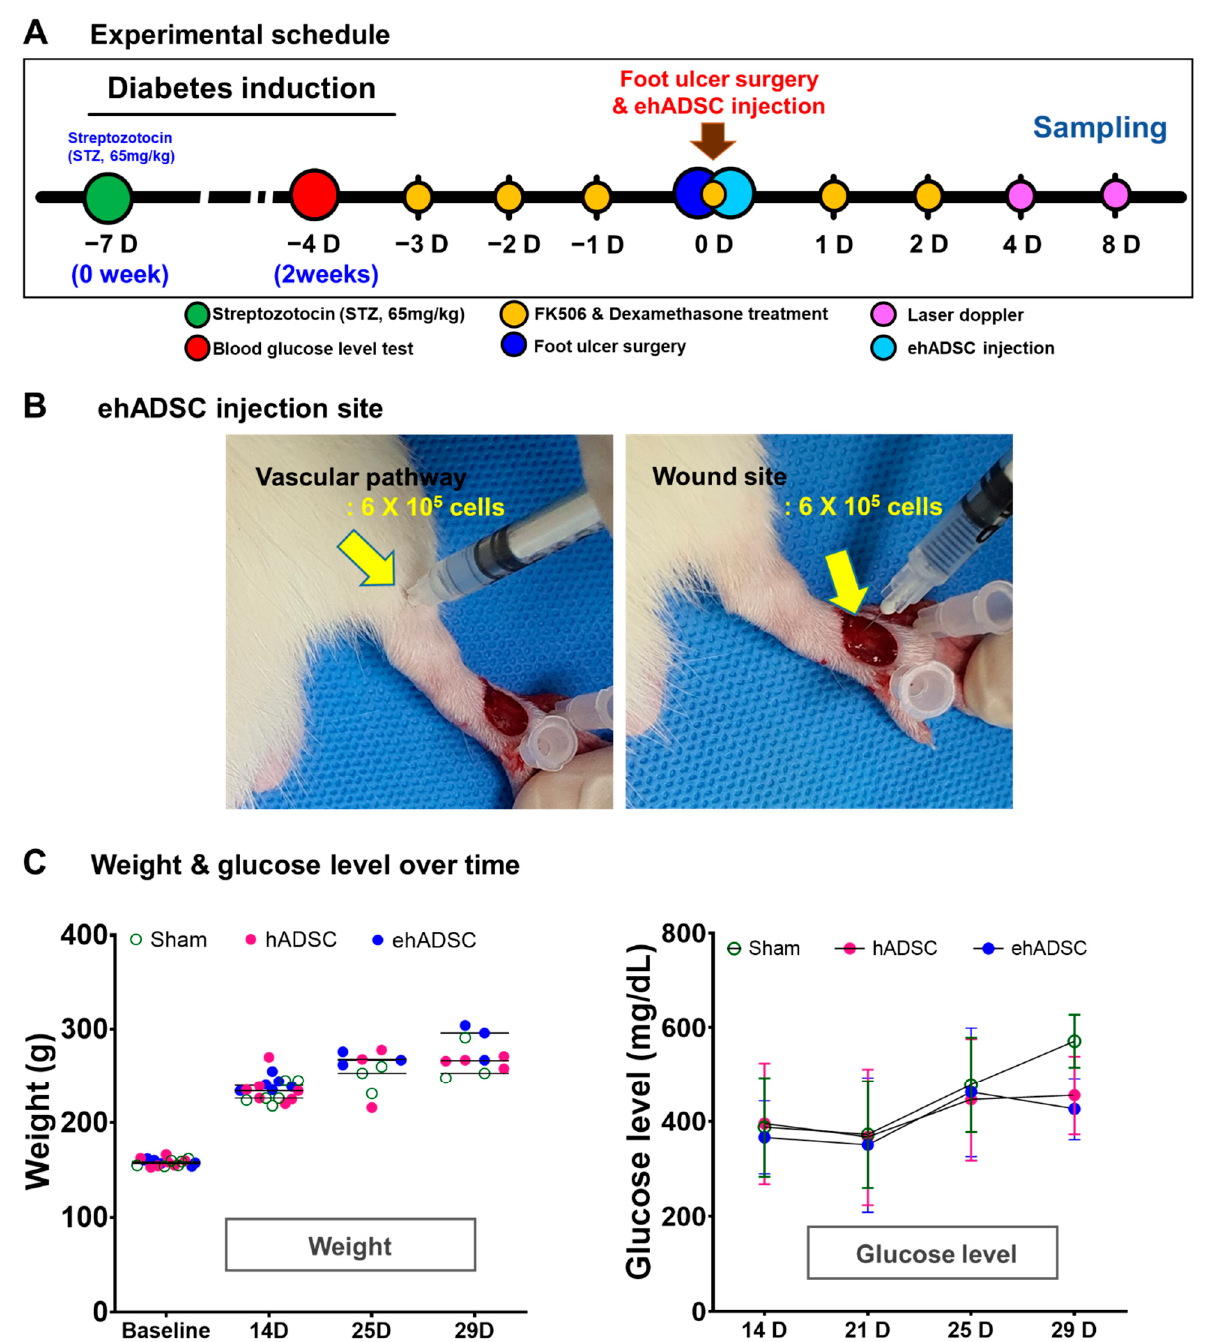
Figure 3. Experimental schedule, body weight, and blood glucose level. ( A ) In vivo experimental schedule. Diabetes was induced by intraperitoneal injection of streptozotocin (STZ, 65 mg/kg) in 6-week-old male Sprague–Dawley rats. On the fourth day of immunosuppressant administration, ehADSCs and hADSCs were injected topically into the foot near the arti fi cial wound. Sampling was performed on days 4 and 8 after administration. ( B ) ADSCs injection site and route. ADSCs were injected around the vascular pathway (left) and near the wound (right). ( C ) Body weight and blood glucose level. There was no signi fi cant di ff erence in body weight. There was no di ff erence among groups in blood glucose levels until day 25, and blood glucose levels in ehADSC decreased on day 29, but there was no signi fi cant di ff erence among groups.